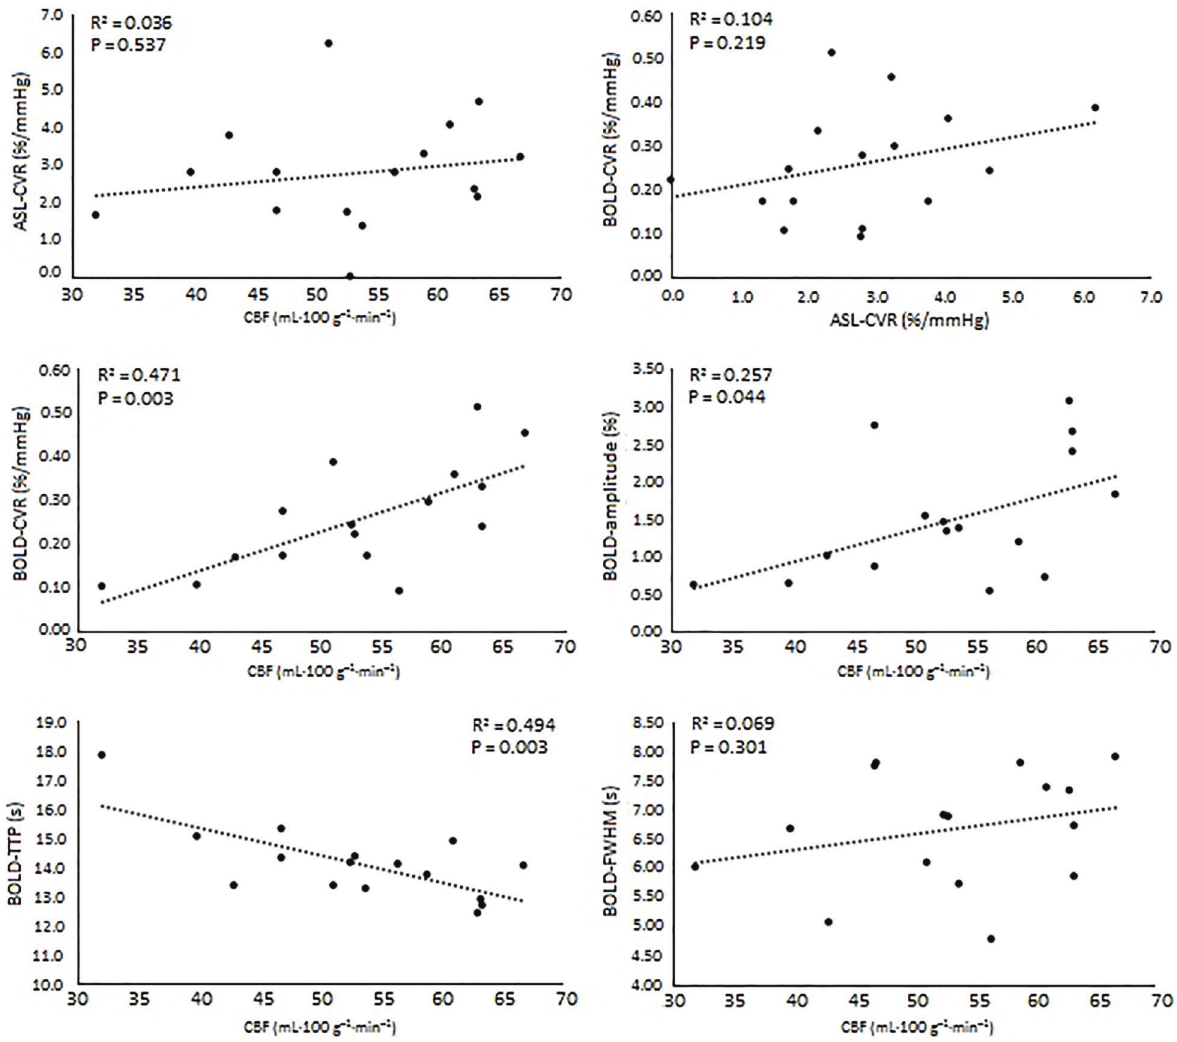
Figure 6. Relationship between blood oxygenation level-dependent (BOLD) contrast and pulsed arterial spin labeling (ASL) measurements across the gray matter for all young and elderly subjects (n=16). CVR: cerebrovascular reactivity; TTP: time-to-peak; FWHM: